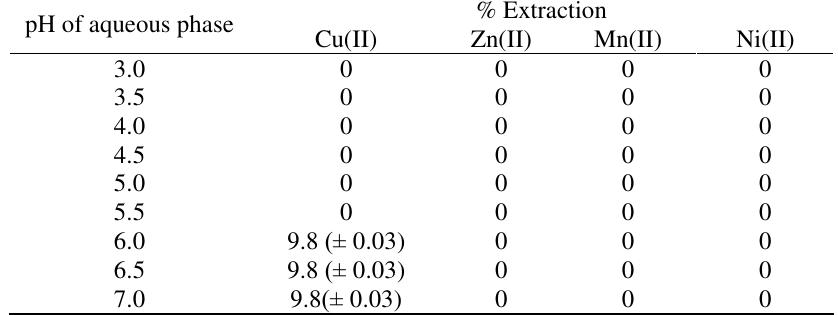
Table 1. Effect of the pH on competitive extraction of Cu(II), Mn(II), Zn(II) and Ni(II).